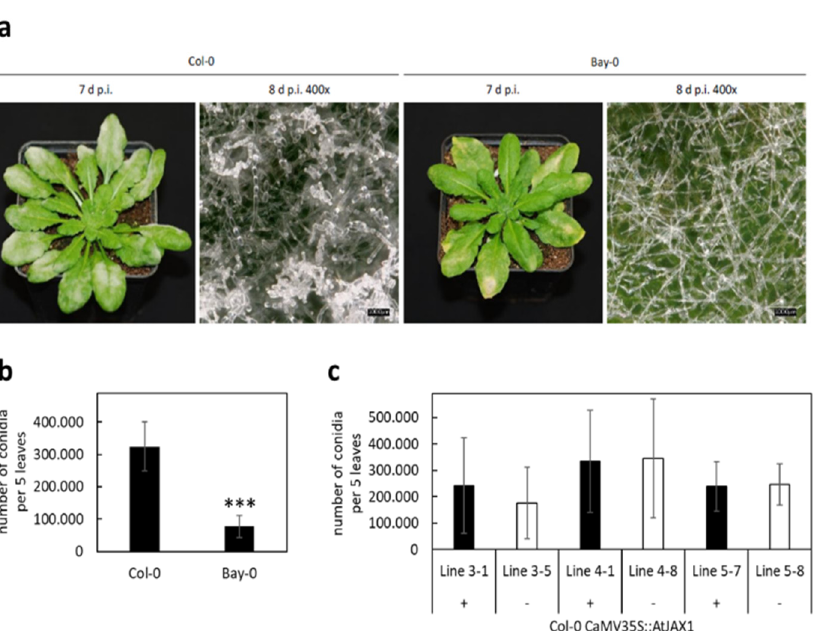
Figure 3. Disease severity of Arabidopsis Col-0 and Bay-0 inoculated with Golovinomyces orontii . Arabidopsis plants of ecotype Col-0 ( AtJAX1Stop ) and Bay-0 ( AtJAX1 ) were inoculated with G. orontii . ( a ) Macroscopic evaluation was performed at seven and eight days post inoculation (d p.i.) as indicated, scale bars equal 100 µ m. ( b ) Quantification of disease severity was performed by rinsing five infected leaves of twelve plants of each ecotype with water and counting of conidia at seven d p.i. ( c ) Disease severity of Col-0 plants complemented with a full length AtJAX1 construct (+) and azygous sibling plants ( − ) was calculated from five infected leaves of each plant at seven d p.i. by rinsing with water and counting of conidia. Mean values are given in ( b , c ) ± standard deviation. Significant differences were determined using Student’s t -test and are indicated with an asterisk ( P < 0.001: ***).